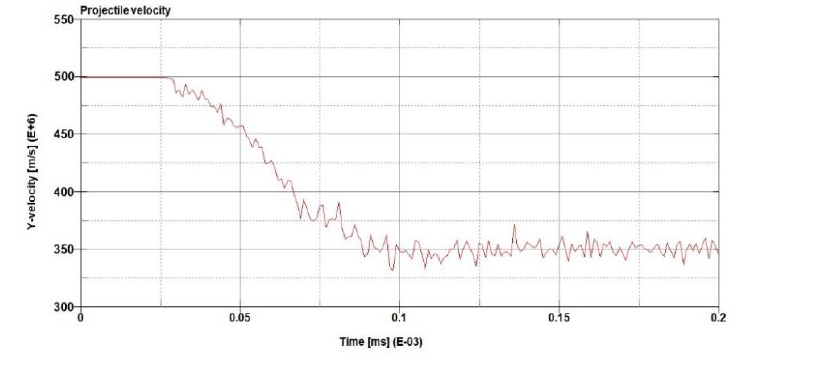
Figure 8 – Velocity of the projectile in relation to time Рис. 8– Cкорость снаряда в зависимости от времени Слика 8 – Брзина пројектила у зависности од